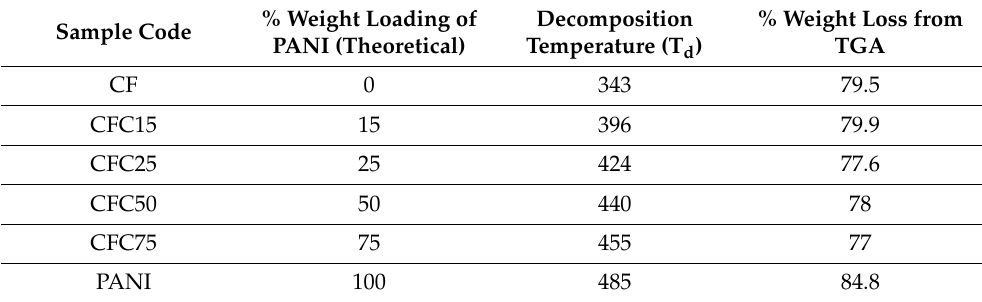
Figure 1. ( a )TGA curve of CF, PANI, CFC15, CFC25, CFC50, and CFC75, ( b )FTIR spectra of CF, PANI, and its composites, and ( c ) CFC50 before and after the adsorption of Cr(VI). Table 2. Decomposition temperature and % weight loss with varying composition of PANI.